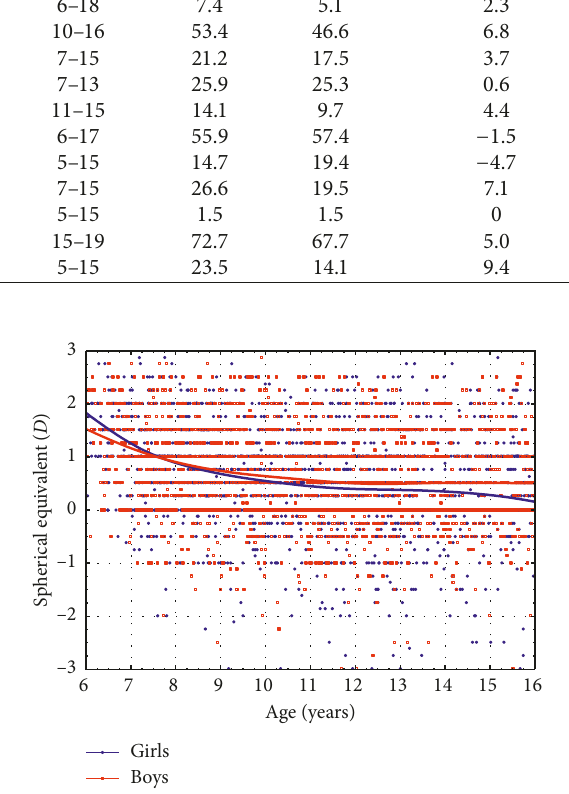
Figure 1: Spherical equivalent in relation to the age of boys (red line) and girls (blue line). Regression lines are obtained using distance-weighted least squares fitting